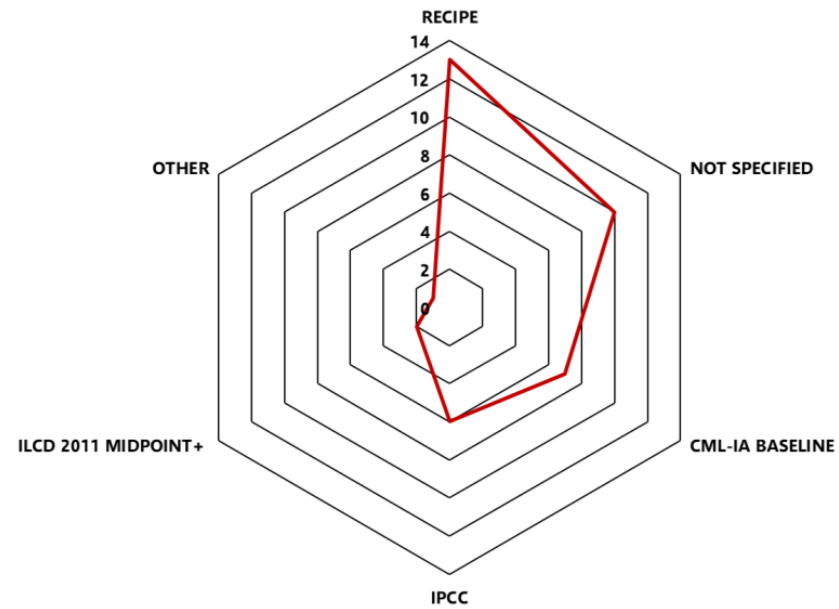
Figure 3. Most used impact categories by authors.